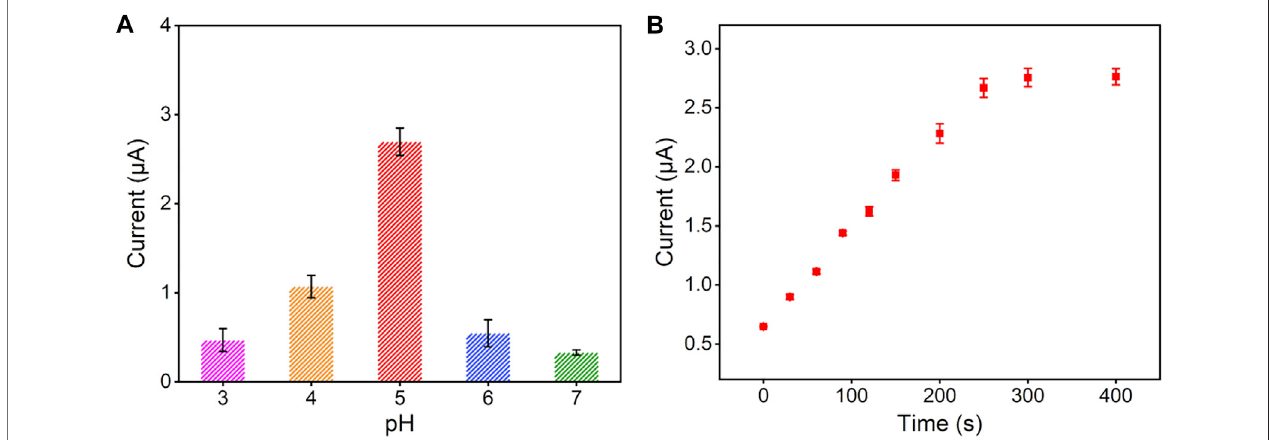
FIGURE 4 | Effect of experimental conditions on the detection performance of Hg 2+ : (A) pH of supporting electrolyte and (B) preconcentration time. The concentration of Hg 2+ is 1 μ M and the error bars represent the standard deviations (SD) of three measurements.